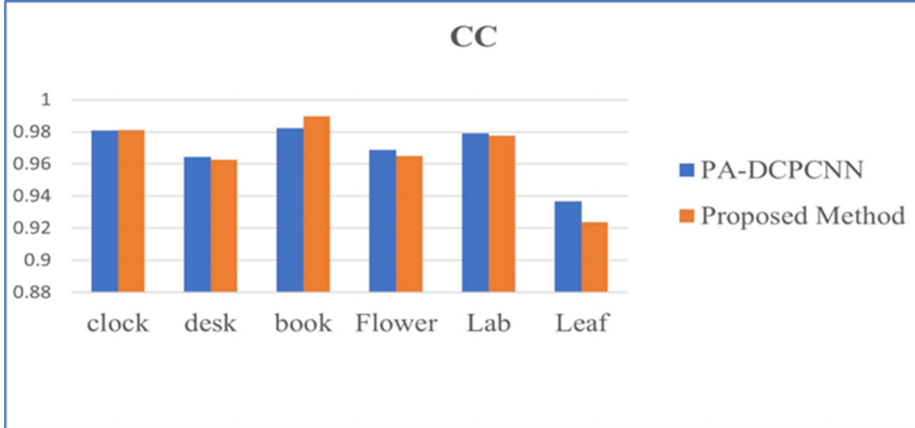
Figure 27. Performance evaluation of image-fusion techniques in reference to CC.